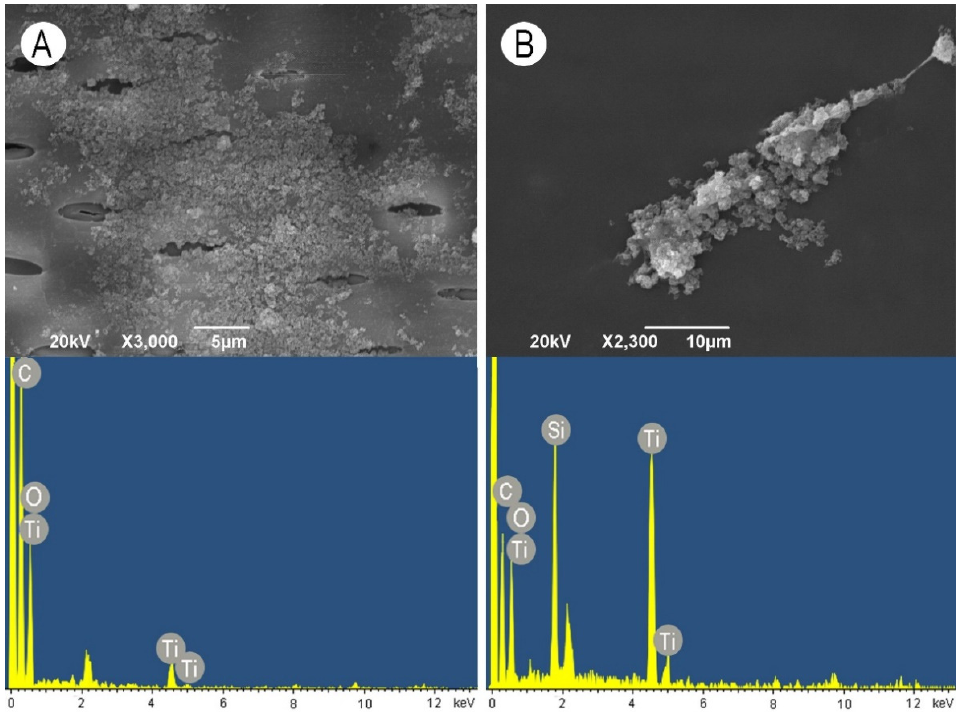
Figure 7. Scanning electron microscopy images of earlywood vessel wall surfaces (upper images) accompanied with the representative EDX spectra showing the elemental composition (bottom images). ( A ) TiO 2 nanoparticles, radial section, scale bar = 5 μ m. ( B ) Aqueous solution of water glass in combination with TiO 2 nanoparticles, radial section, scale bar = 10 μ m.